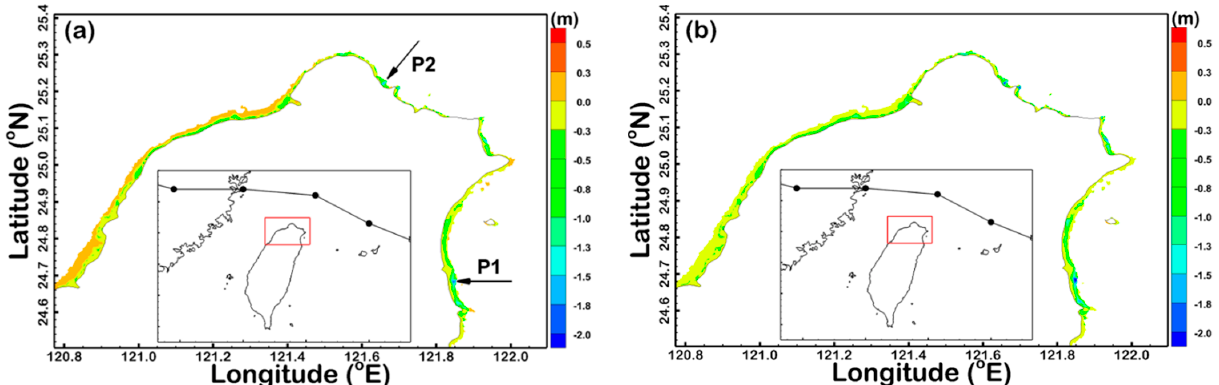
Figure 9. Spatial distribution of the difference in maximum SWH between the scenarios of ( a ) S_NO1 and S_NO2 and ( b ) S_NO1 and S_NO3 during the passage of Super Typhoon Maria in 2018. The areas with water depths greater than − 20 m are shown.